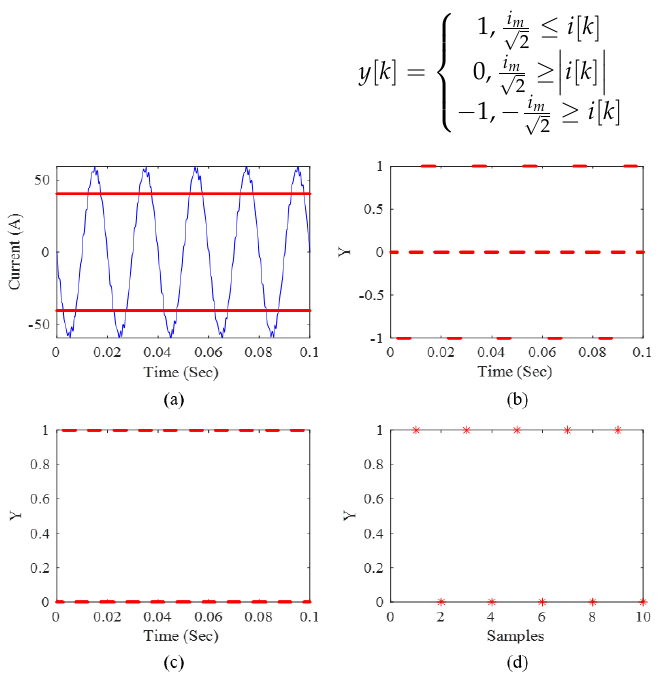
Figure 5. ( a ) The stator current with red line representing the RMS value, ( b ) the samples validating the conditions given in b, ( c ) the shifting of negative samples towards positive side by taking modulus, and ( d ) merging the consecutive samples of same value in